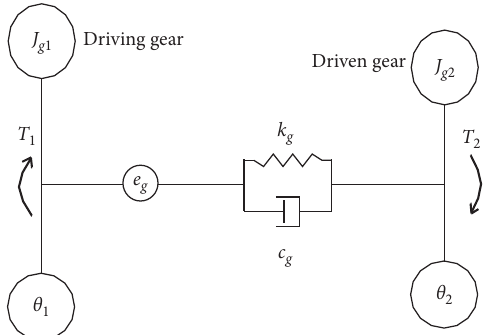
Figure 3: The dynamics model of a gear pair.